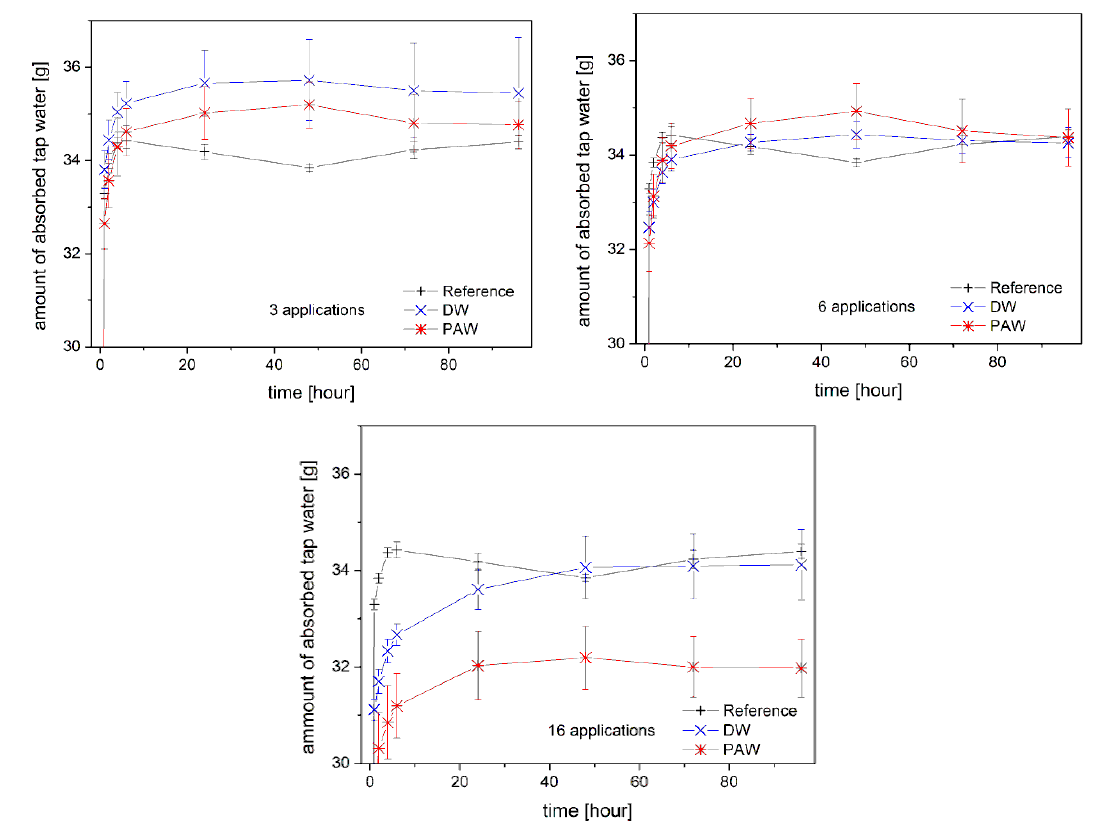
Figure 6. Absorption of tap water at the selected number of DW and PAW applications.